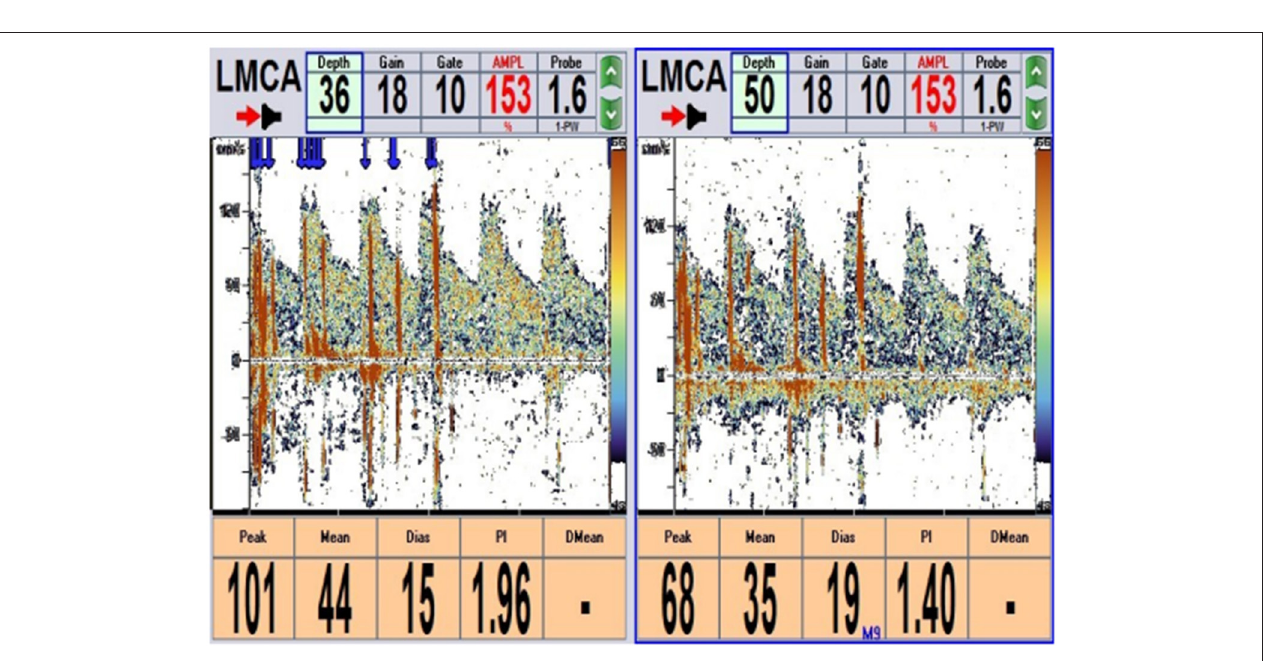
FIGURE 2 | cTCD: More than 25 microbubbles were detected after 2s of Valsalva maneuver detecting from the left middle cerebral artery (LMCA) (single-channel and double depth) (blue arrow). cTCD, contrast transcranial Doppler